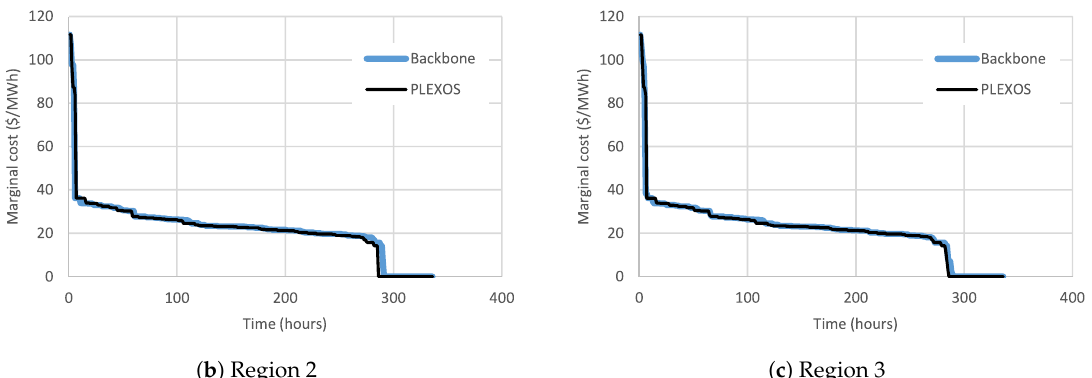
Figure 10. Marginal cost of electricity in day-ahead market simulation in ( a ) region 1, ( b ) region 2 and ( c ) region